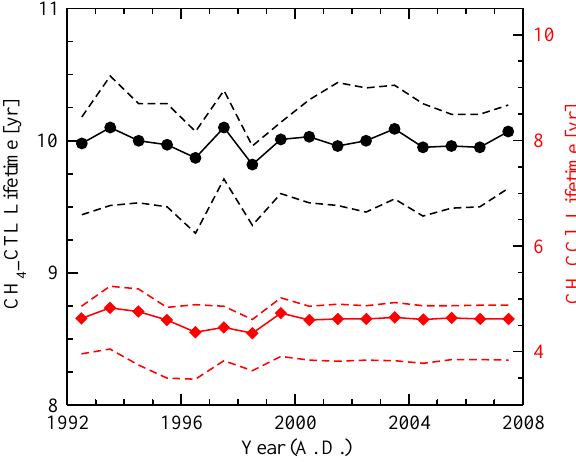
Fig. 12. Time series of median (symbols) and ranges (broken lines) of atmospheric lifetimes of CH 4 (black) and CH 3 CCl 3 (red). Note that the mean CH 4 lifetimes for EXTRA (9.96 ± 0.08yr) and CTL (9.99 ± 0.08yr) fluxes agree within their interannual variabil- ity. A comparison of CH 3 CCl 3 lifetimes calculated using Eq. (5) and gridded photochemical destruction rates is shown in Fig. S22 (ACTM